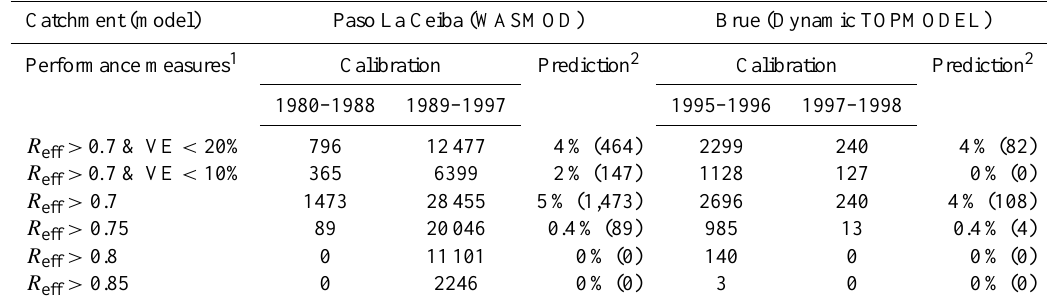
Table 4. Number of behavioural parameter-value sets for different Nash-Sutcliffe based performance measures.